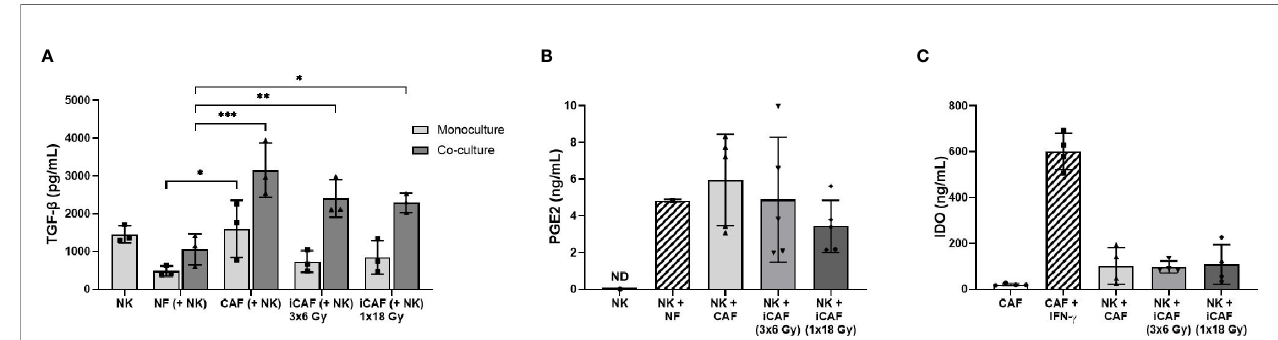
FIGURE 6 | Effects of radiation on cancer-associated fi broblast (CAF)-derived immunomodulators. (A, B) Protein levels of secreted TGF- b and PGE2 in culture supernatants measured by ELISA. (C) Intracellular IDO protein expression in CAF cell lysates analyzed by ELISA. In (C) , positive control is non-irradiated CAFs stimulated with IFN- g and negative control non-irradiated CAFs cultured without stimulation. Data represents mean (± SD) values from three (A) , fi ve (B) or four (C) different CAF donors. P -values between NFs and CAFs in (A, B) were determined using one-way ANOVA with Tukey correction for multiple comparisons, whereas P -values between groups of monocultures and co-cultures in (C) were determined using two-way ANOVA with Dunnett correction for multiple comparisons. * P < 0.05, ** P < 0.01 and *** P